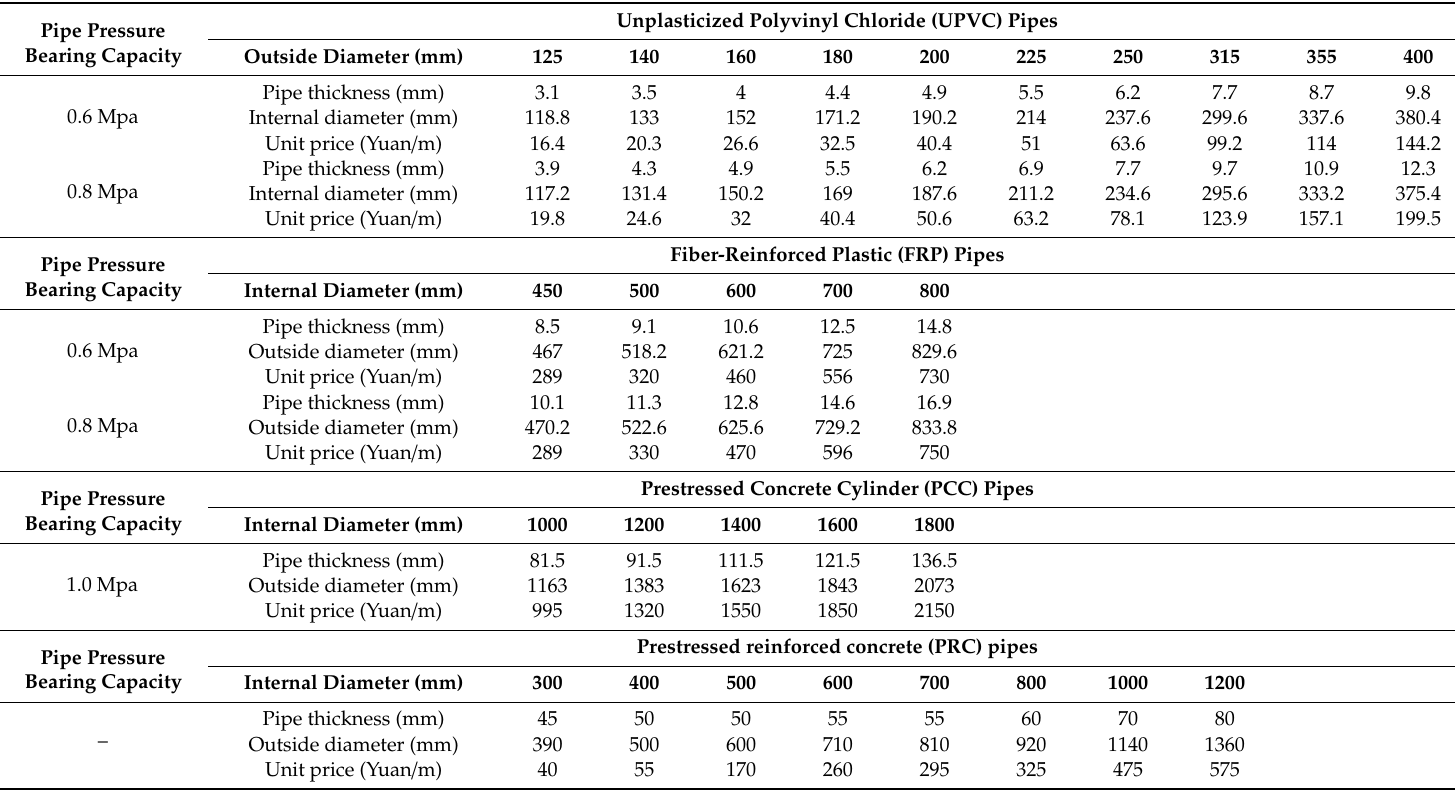
Table 2. Unit prices (Yuan / m) of di ff erent